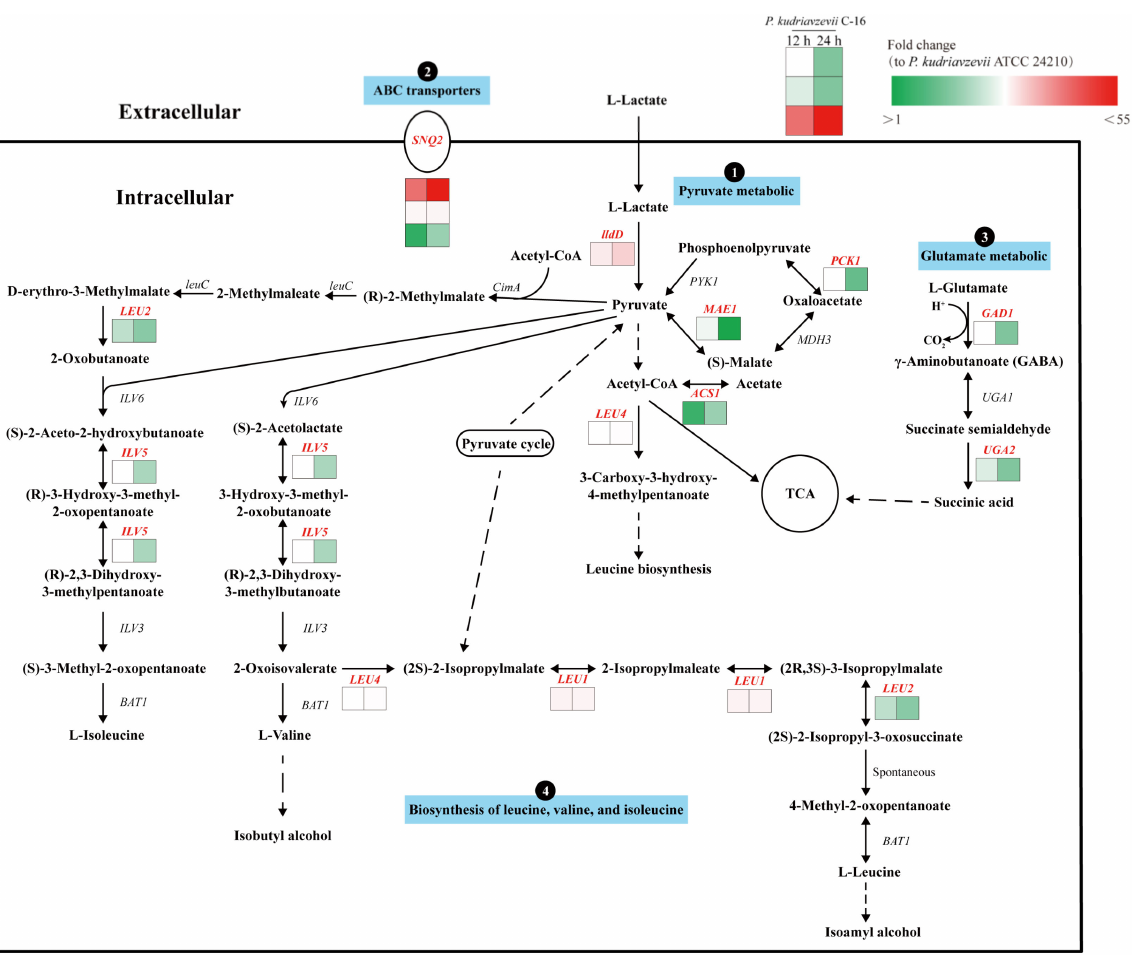
Figure 5. Pathways of P. kudriavzevii C-16 response to lactic acid stress. Red letters mean upregulated genes. Transcripts of P. kudriavzevii C-16 are shown near the pathway as a heat map, based on fold-changes in transcript levels relative to the type strain ATCC 24210. Colour legend is shown at the top right of the